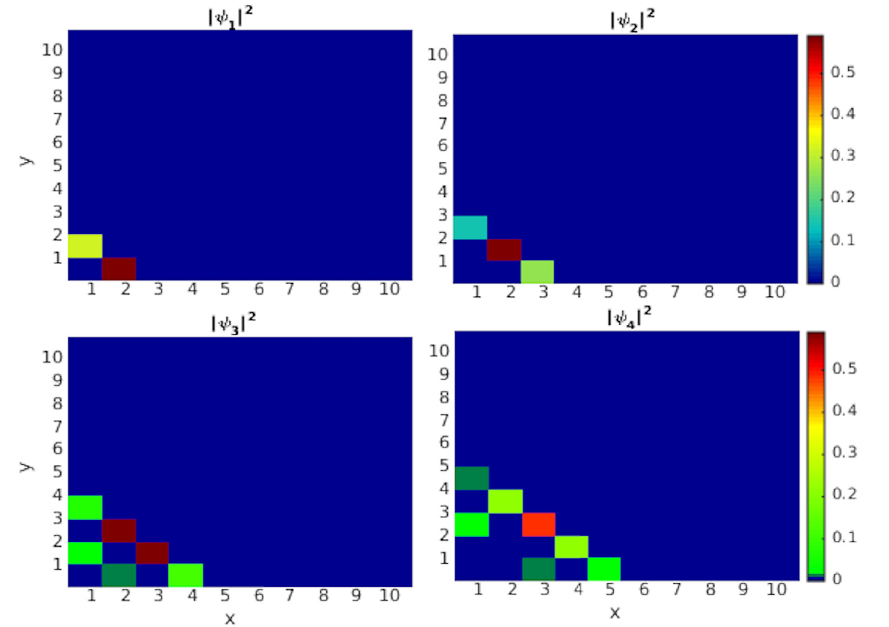
Fig. 4. Propagation of different orders of recursion wave-vectors. The coupling parameters are J e = J h = 0 . 3 eV, C e = 0 . 2 eV and C h = 0 . 15